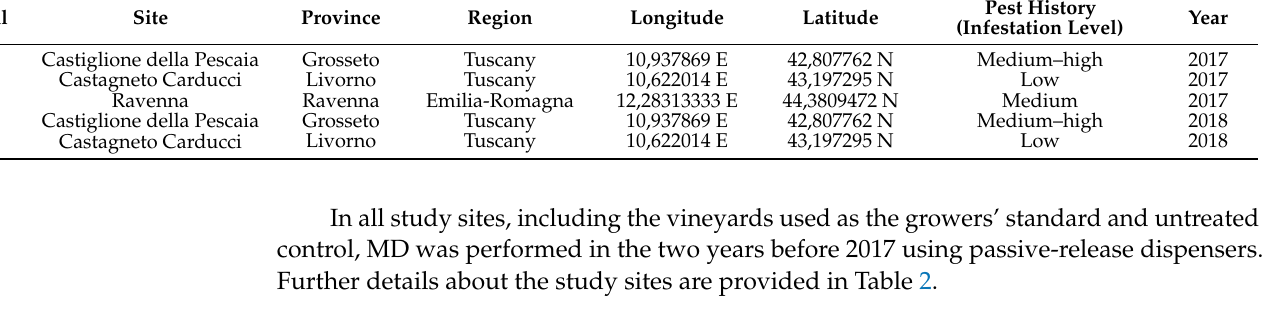
Table 2. Details of the Italian vineyards where Lobesia botrana mating disruption trials were performed.